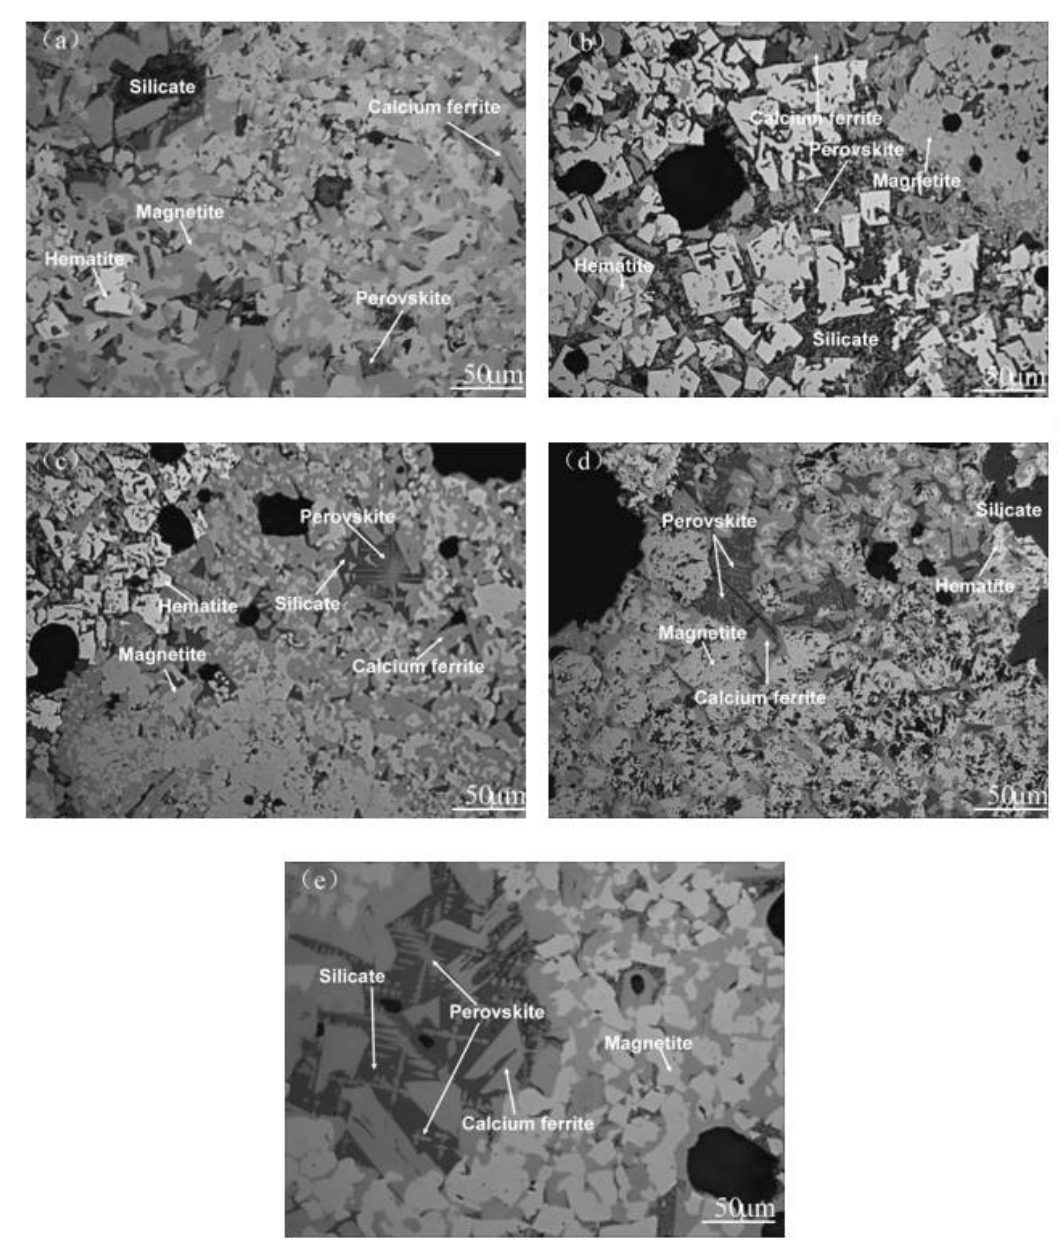
Figure 7. Microstructure of the sinter with various TiO 2 contents: ( a ) w (TiO 2 ) = 1.75%, ( b ) w (TiO 2 ) = 2.45%, ( c ) w (TiO 2 ) = 3.15%, ( d ) w (TiO 2 ) = 3.85%, ( e ) w (TiO 2 ) = 4.55%.